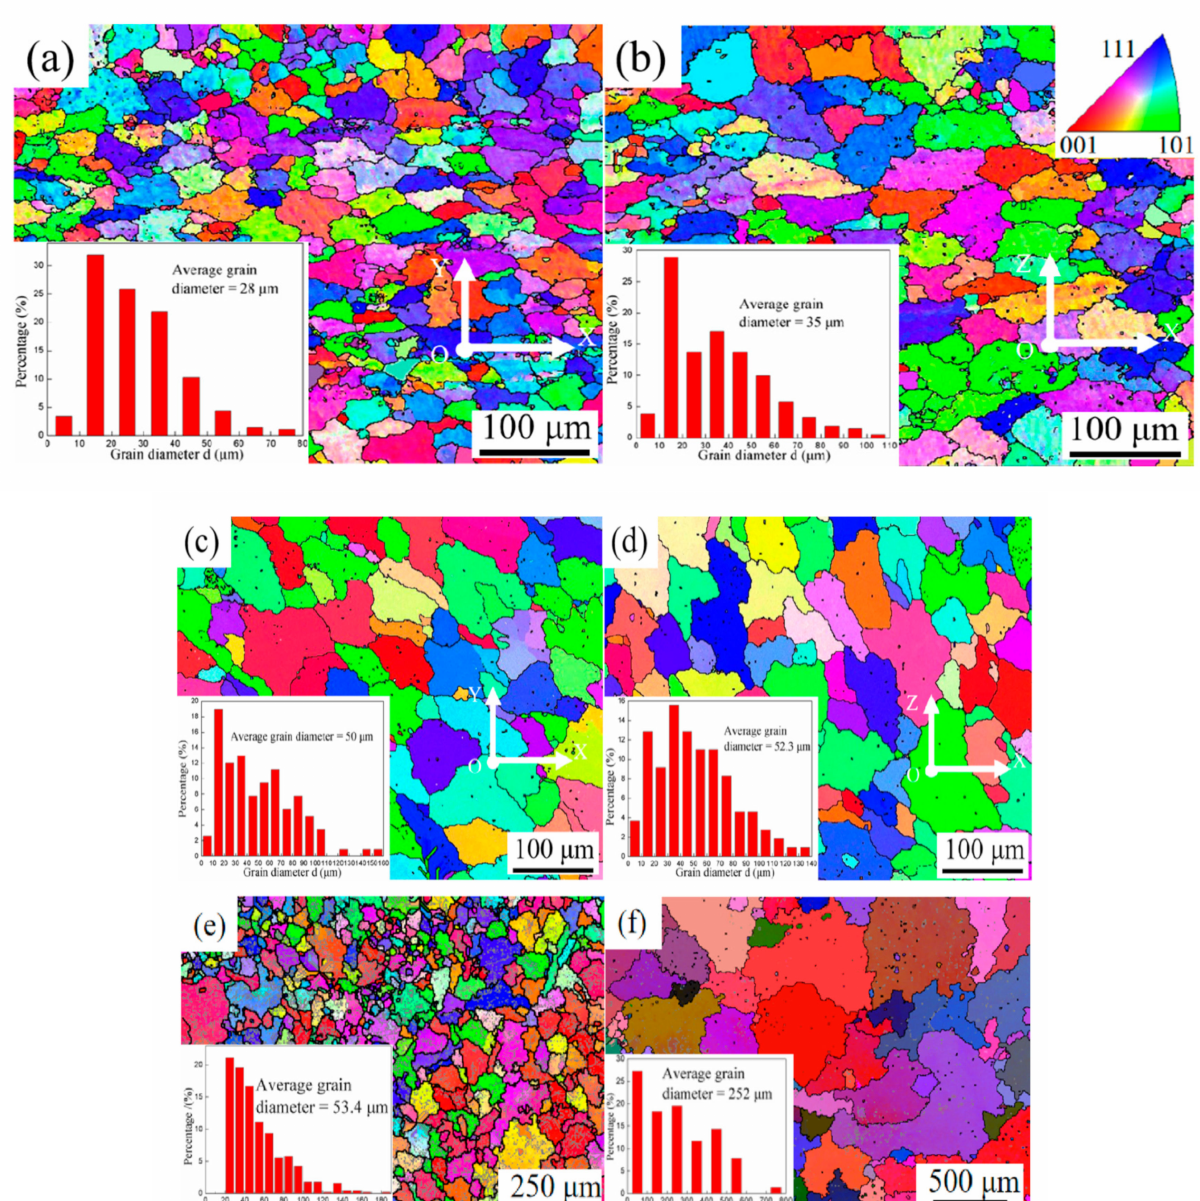
Figure 7. EBSD graphs and grain size diagrams of samples: ( a ) face XOY of WAAM-CMT-printed TiB 2 /AlSi7Mg0.6 composites; ( b ) face XOZ of WAAM-CMT-printed TiB 2 /AlSi7Mg0.6 composites; ( c ) face XOY of WAAM-CMT-printed TiB 2 /AlSi7Mg0.6 composites after T6 heat treatment; ( d ) face XOZ of WAAM-CMT-printed TiB 2 /AlSi7Mg0.6 composites after T6 heat treatment; ( e ) WAAM-CMT- printed AlSi7Mg0.6 alloy; ( f ) casted AlSi7Mg0.6 alloy. After T6 heat treatment, the value of yield strength, ultimate tensile strength, and elongation (A) in two directions were the same on the whole, indicating that T6 heat treatment was an effective method to eliminate the anisotropy of WAAM-CMT-printed TiB 2 /AlSi7Mg0.6 composites. Besides, the value of yield strength and ultimate tensile strength in two directions both clearly increased after heat treatment, while there was a decrease of elongation in two